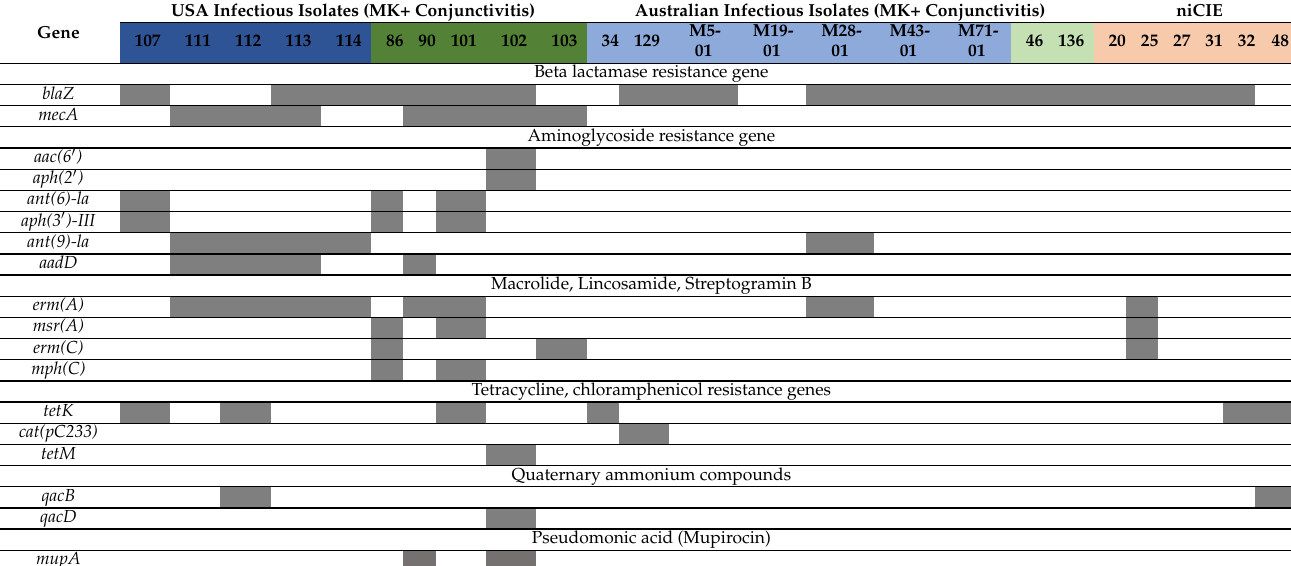
Table 2. Acquired antimicrobial resistance genes in S. aureus isolates from different ocular conditions. USA Infectious Isolates (MK+ Conjunctivitis)